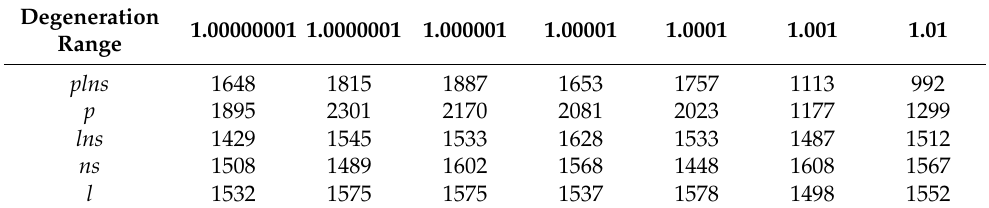
Table 6. Effect of degeneration range on low-probability password hits (Rule 5).